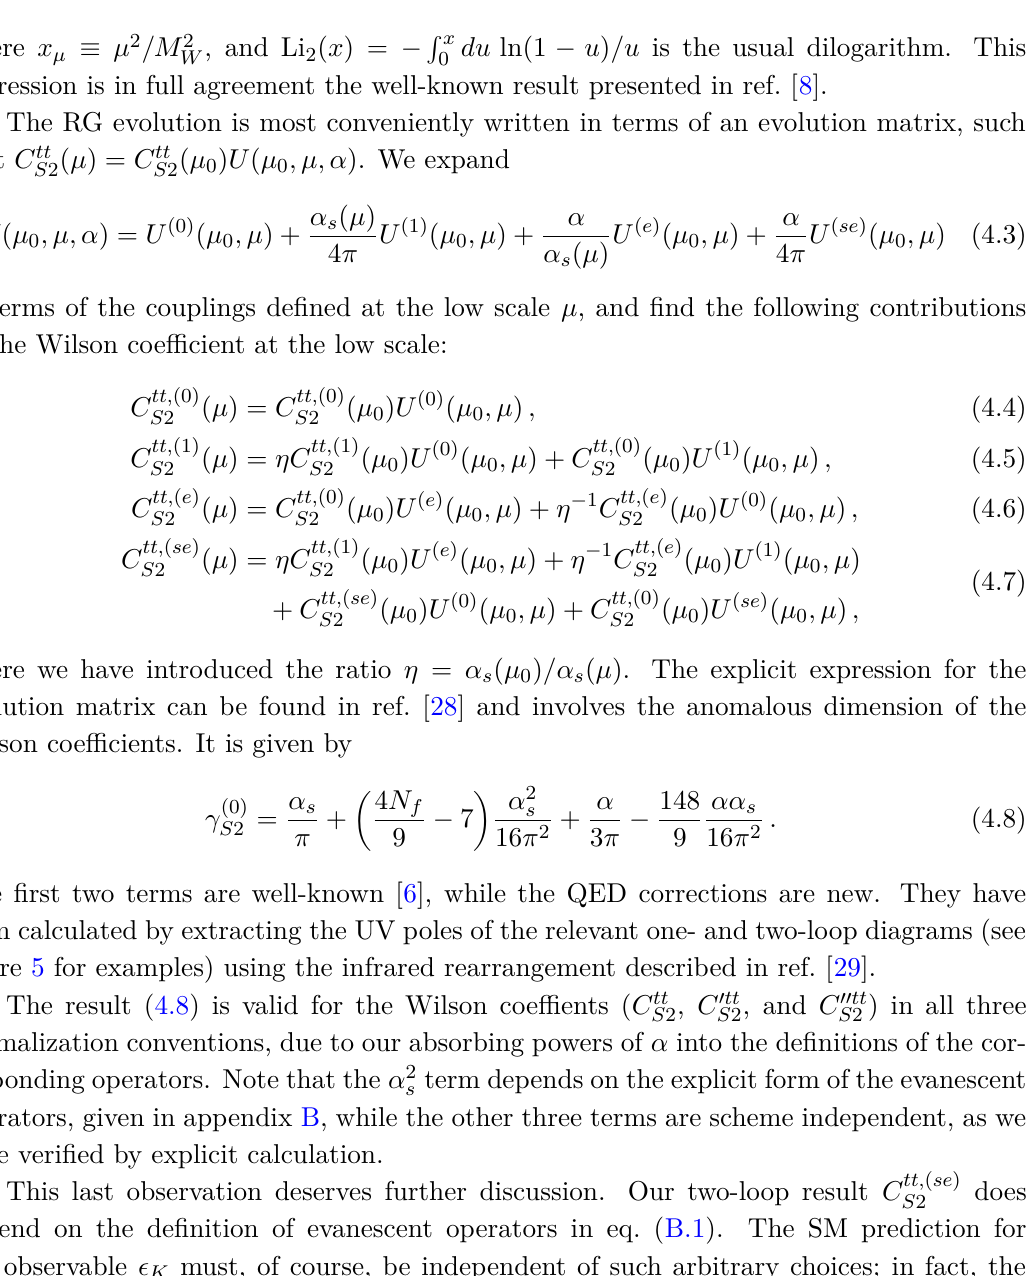
Figure 5 . Sample Feynman diagrams contributing to the two-loop anomalous